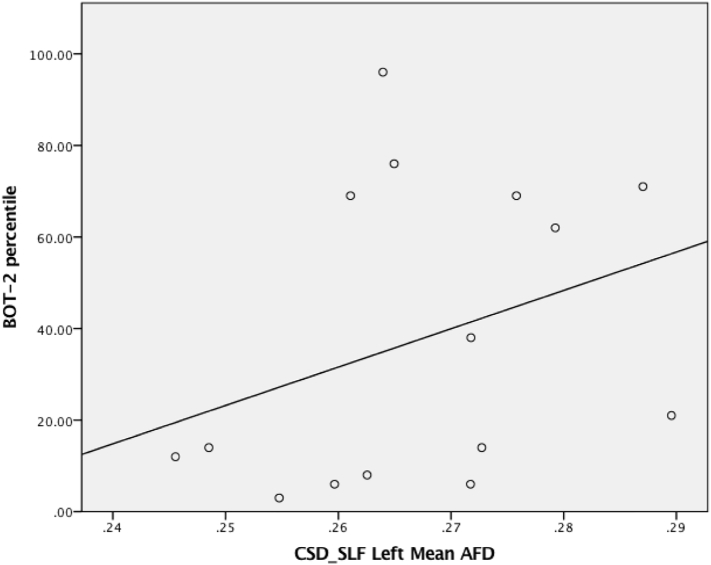
A visual representation of the relationship between mean AFD of the SLF and total BOT-2 percentile ranking. NOTE: AFD- Apparent Fibre Density; SLF –Superior longitudinal fasciculus.